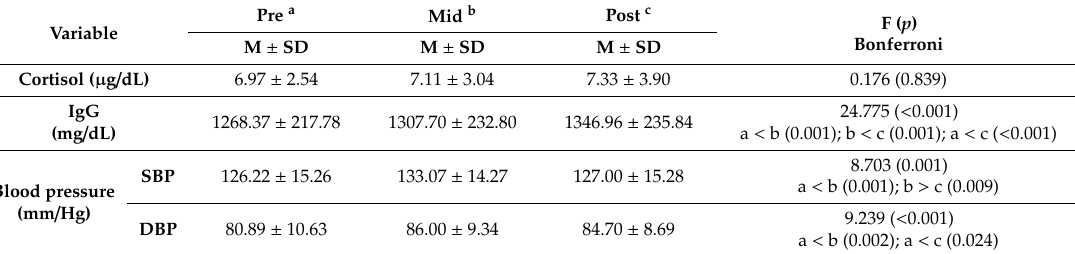
Table 4. Comparison of physiological variables (N =